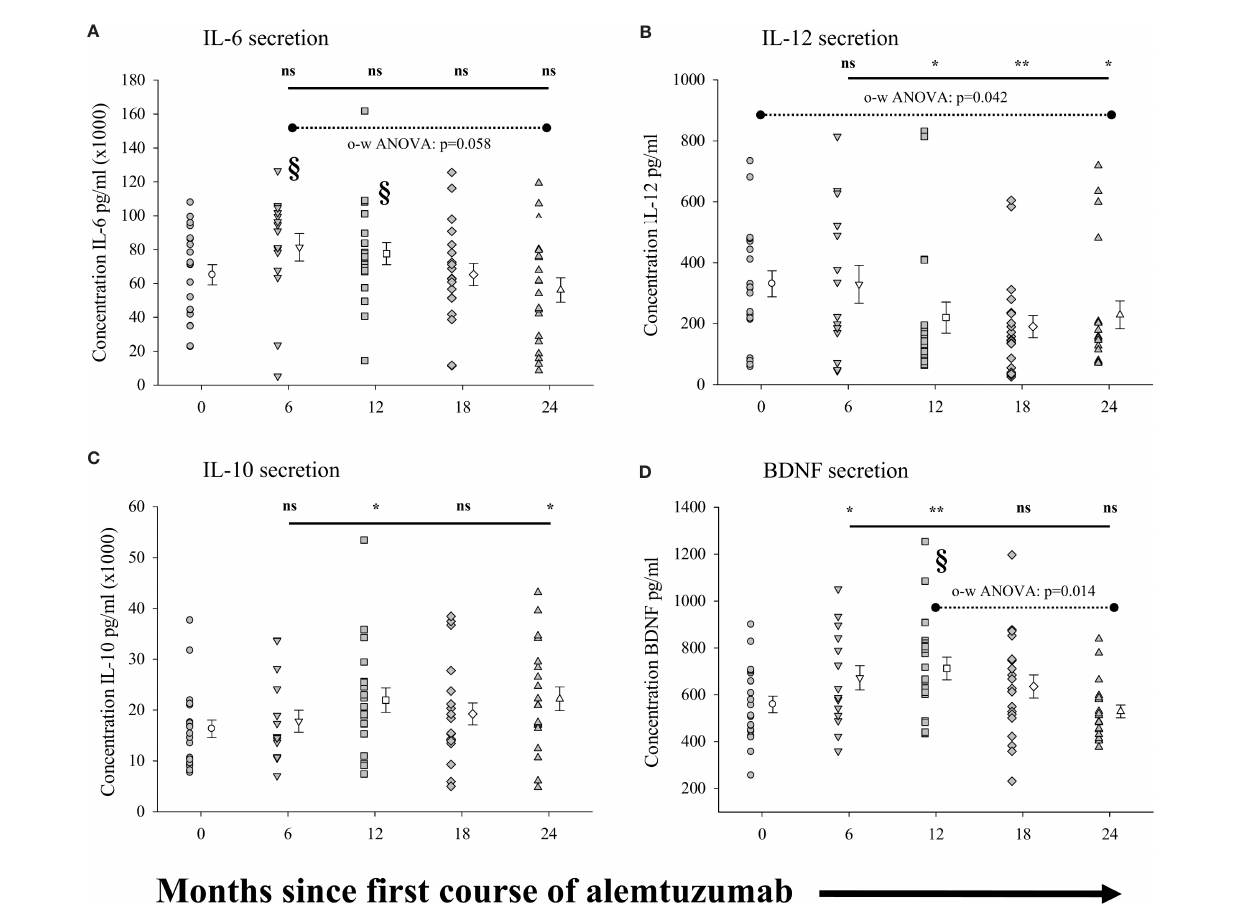
FIGURE 5 | Measures of peripheral blood monocyte function following alemtuzumab treatment: Panels (A – D) illustrate different measures for each treatment cohort (6 month = inverted triangle; 12 month = square; 18 month = diamond; 24 month = triangle; 36 month = hexagon) as compared with a pre-treated patient cohort (circles). Panels (A) (IL-6), (B) (IL-12), (C) (IL-10) & (D) (BDNF) show the concentration (pg/ml) of solutes secreted by stimulated CD14 + B monocytes. Data for each cohort in each panel shows the individual values for each patient in the cohort ( fi lled circles, triangles etc.) adjacent to the mean ( ± SEM) for the group as a whole (open circles, triangles etc.). Signi fi cant changes compared to the pre-treated patient cohort are identi fi ed as ** (p ≤ 0.01), * (p ≤ 0.05) or ns (not signi fi cant), and are plotted above the corresponding cohort on top of the solid back line. Signi fi cant differences compared to the 24-month cohort are identi fi ed as § (p<0.05). One-way ANOVA (A, B, D) with corresponding p-value is shown with a dashed line across the top of the data points